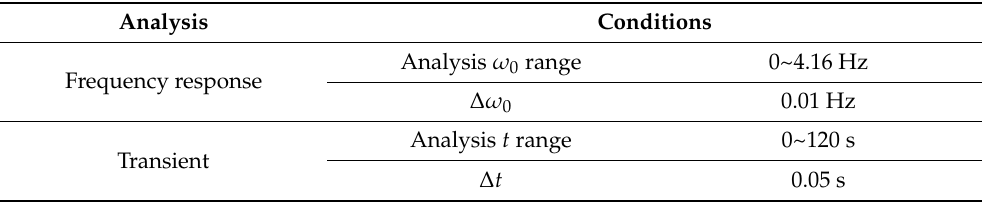
Table 2. Analysis conditions for frequency response and transient analyses.